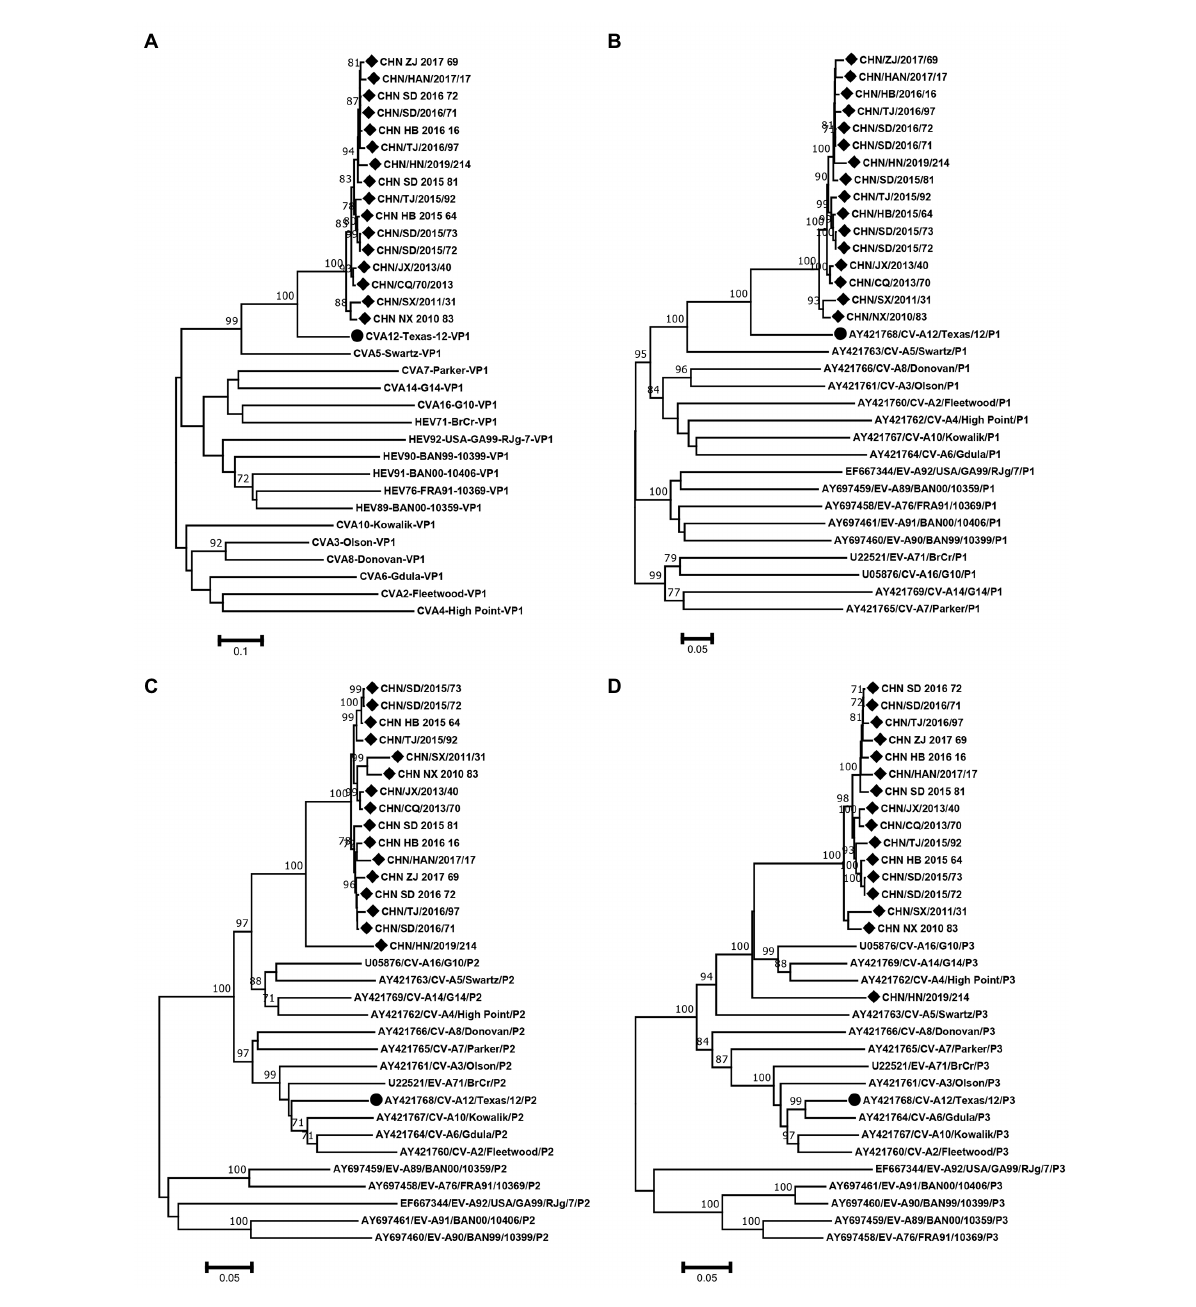
FIGURE 4 Neighbor-joining phylogenetic trees of (A) VP1, (B) P1, (C) P2 and (D) P3 were constructed based on 16 CVA12 strains from this study and EV-A prototype strains. The 16 CVA12 strains from this study are represented by a diamond, and CVA12 prototype strain is represented by a circle. The numbers on these nodes indicate the bootstrap support for that node (the percentage of 1000 bootstrap replicates). The scale bars indicate the genetic